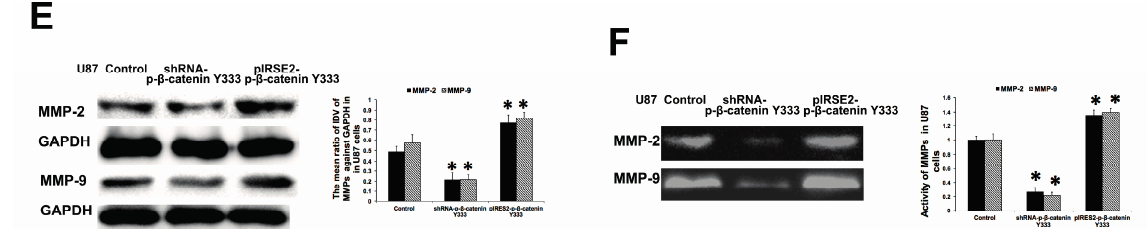
Figure 6. The effects of p- β -catenin Y333 knockdown or overexpression on the migration, invasion, and MMP expression and activity of U87 cells. The effects of p- β -catenin on the malignant biological behavior of glioma cells were investigated by establishing stably transfected U87 cells with p- β -catenin Y333 silencing or overexpression plasmids. p- β -catenin Y333 knockdown attenuated the migration, invasion, and MMP expression and activity in U87 cells, whereas its overexpression enhanced the malignant biological behavior of glioma cells. ( A ) The knockdown transfection efficiency. The expression of p- β -catenin Y333 protein was checked by Western blot assays. p- β -catenin Y333 was significantly inhibited in the shRNA-p- β -catenin Y333 group individually compared with the control